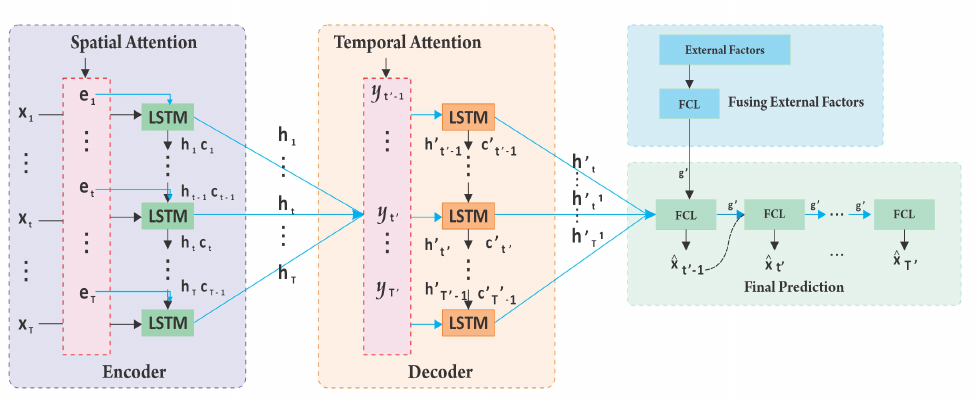
Figure 2. Architecture of ANST.